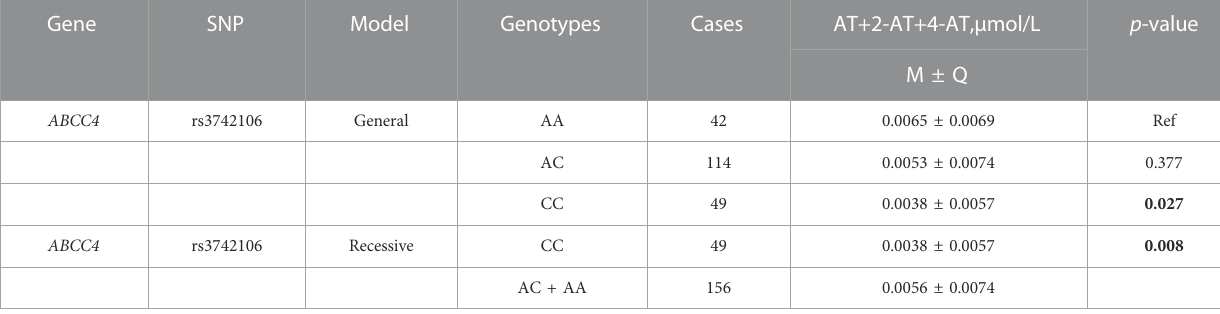
TABLE 5 Association analysis between genetic variants and plasma concentration of AT+2-AT+4-AT. Gene SNP Model Genotypes